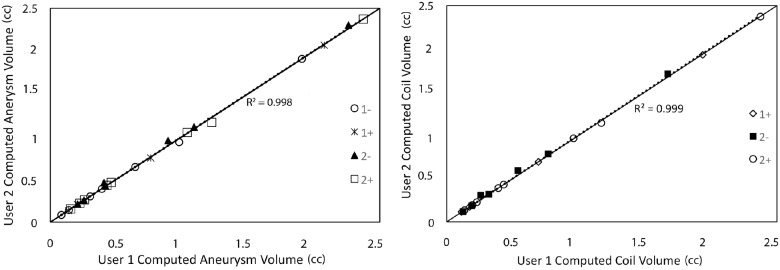
Comparison of the computed sac and coil volumes by two investigators blinded from each other’s results.